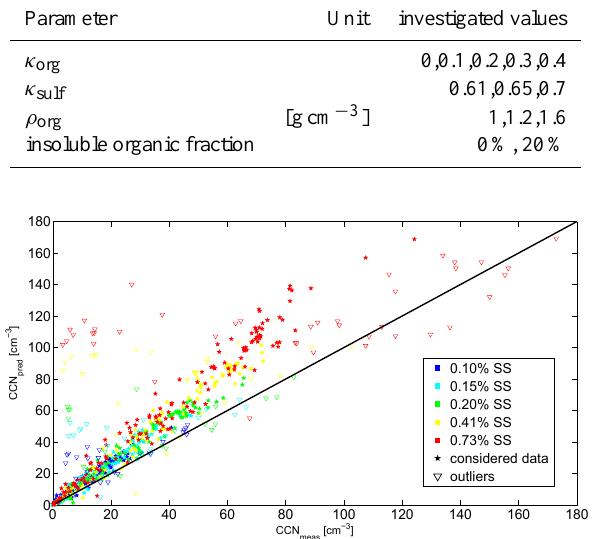
Fig. 2. Sample result of the closure study for permutation 62 ( κ org = 0 . 3, κ sulf = 0 . 65, ρ org = 1gcm − 3 , no insoluble organic fraction as- sumed). The closure is overpredicted for all five